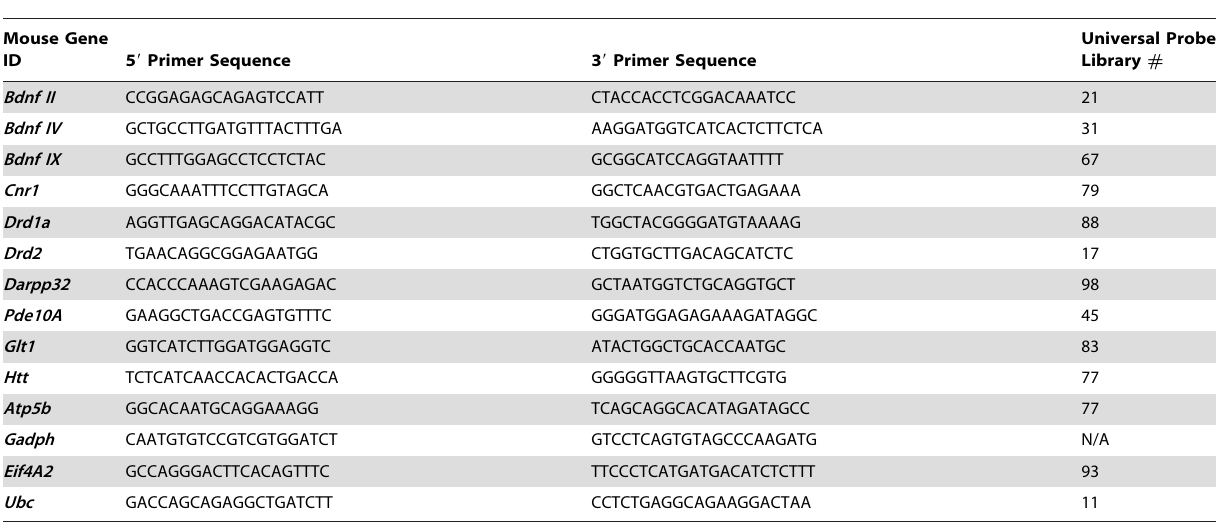
Table 3. Quantitative Polymerase Chain Reaction (qPCR) information.